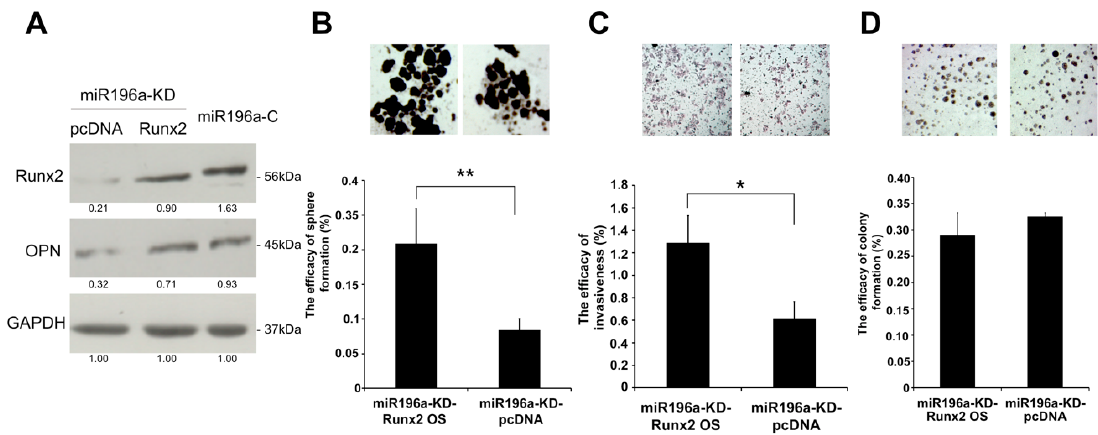
Figure 6. Restoration of Runx2 in miR-196a-downregulated PLC cells increased self-renewal and invasiveness. ( A ) Western blot confirmed the rescue of expression of Runx2 and osteopontin (OPN) after expression of Runx2 in miR-196a-downregulated PLC cells. ( B – D ) Restoration of Runx2 in miR-196a-downregulated PLC cells rescued the efficacy of sphere formation ( B ) and invasiveness ( C ), but not colony formation ( D ) (original magnification, ×50 ( B ), ×100 ( C ), ×25 ( D ), * p < 0.05, ** p < 0.01).